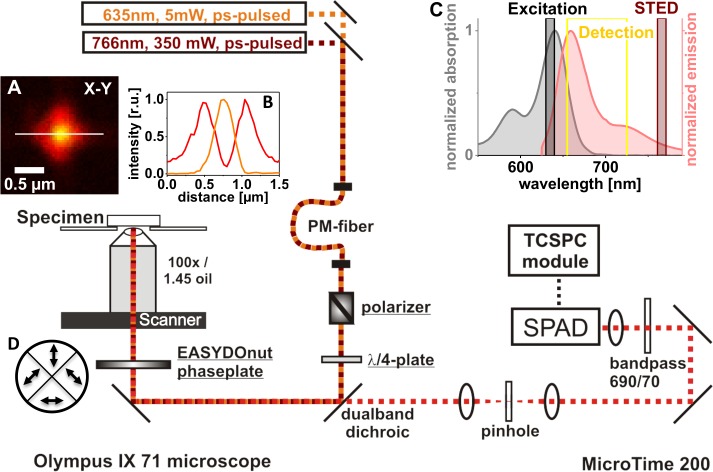
Setup realizing a STED upgrade.Components integrated into the MicroTime 200 confocal microscope (PicoQuant, Germany) in order to reach diffraction-unlimited imaging are underlined. The laser beam inducing stimulated emission (766 nm) is coupled into the same polarization-maintaining (PM) fiber as the excitation light from the ps-pulsed laser diode at 635 nm. The polarizer (Glan-Thompson prism from Artifex, Germany) is not mandatory, as the linear polarization of the lasers used is preserved mostly by the fiber. Still, as the quality of the STED doughnut created by the EASYDOnut phase plate (Abberior, Germany) depends on the polarization state of the 766 nm light, further polarization control may be beneficial. Arrows in inset (D) indicate the slow axis’ direction of each of the phase plate’s segments. The achromatic quarter wave plate (λ/4) changes the polarization state to circular, the state the phase plate works best with. Fluorescence was recorded with a 100 Plan Apo Lambda oil immersion objective from Nikon. Time-correlated single-photon counting (TCSPC) electronics and analysis software were provided by PicoQuant. For single-photon detection, a single-photon avalanche diode (SPAD, PerkinElmer) was used. Inset (A) shows the point spread functions of the excitation (yellow) and STED (red) light as measured by monitoring the backscattered light of an 80 nm gold bead. Inset (B) shows the corresponding profile plots along the white line in (A). In inset (C), the absorption and emission spectra of the dye Abberior STAR635 are given together with the wavelengths of the chosen excitation and STED lasers. The detection window, realized by a 690/70 nm bandpass filter in front of the detector, is indicated as a yellow box.